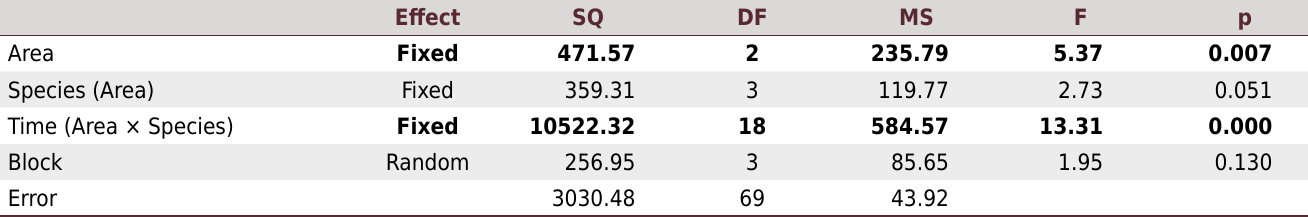
Table 1. Summary of general linear model results for leaf litter decomposition rate